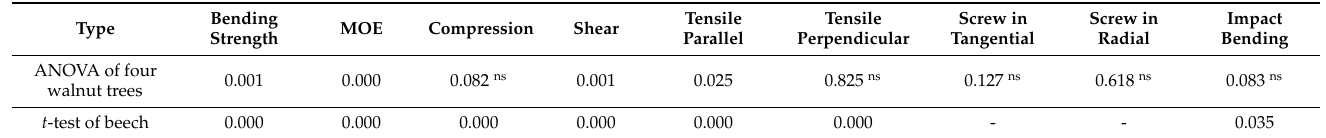
Table 6. Statistical analysis of mechanical